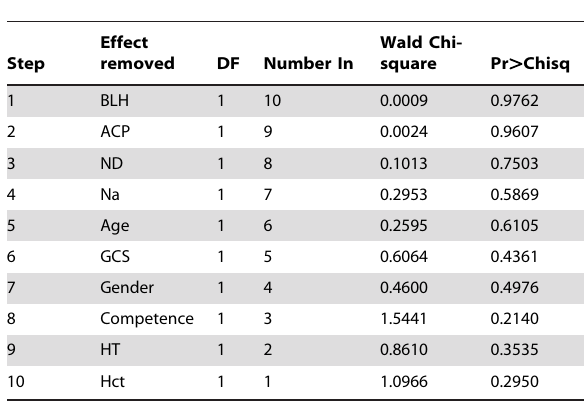
Table 3. Multivariate regression analysis: summary of backward independent variable elimination process for dependent variable RHR.